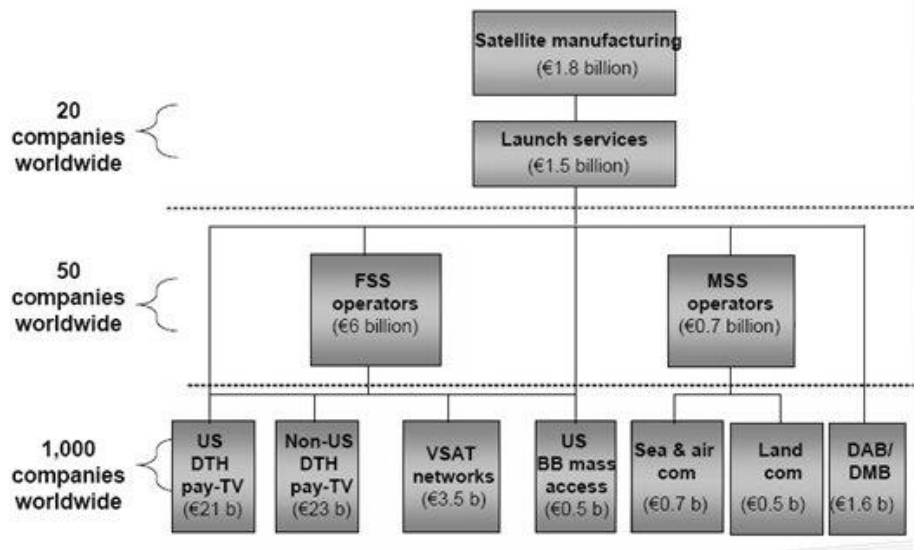
Fig. 3. Satellite technology value chain (ESOA,